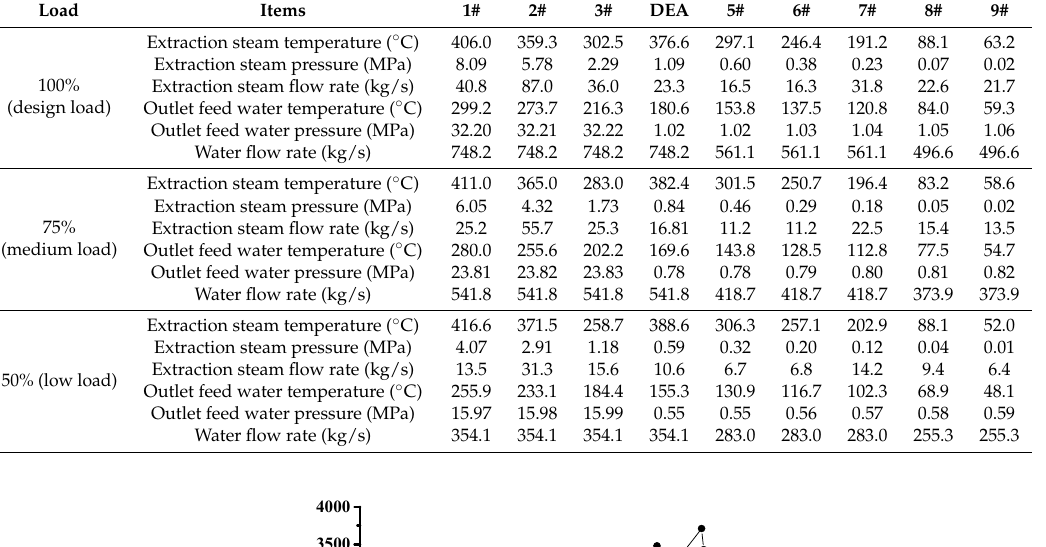
Table 3. Primary thermal parameter of the regenerative system of the case unit.